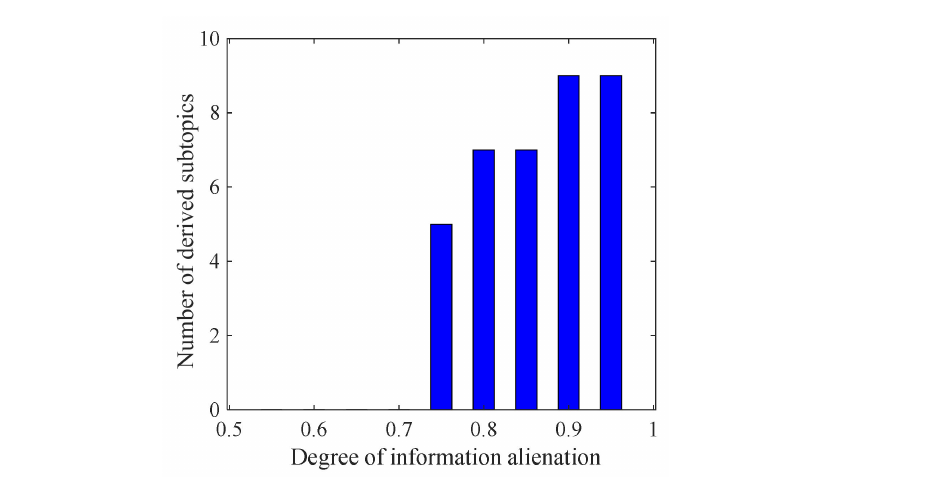
Figure 7. The number of derived subtopics under different information alienation settings.